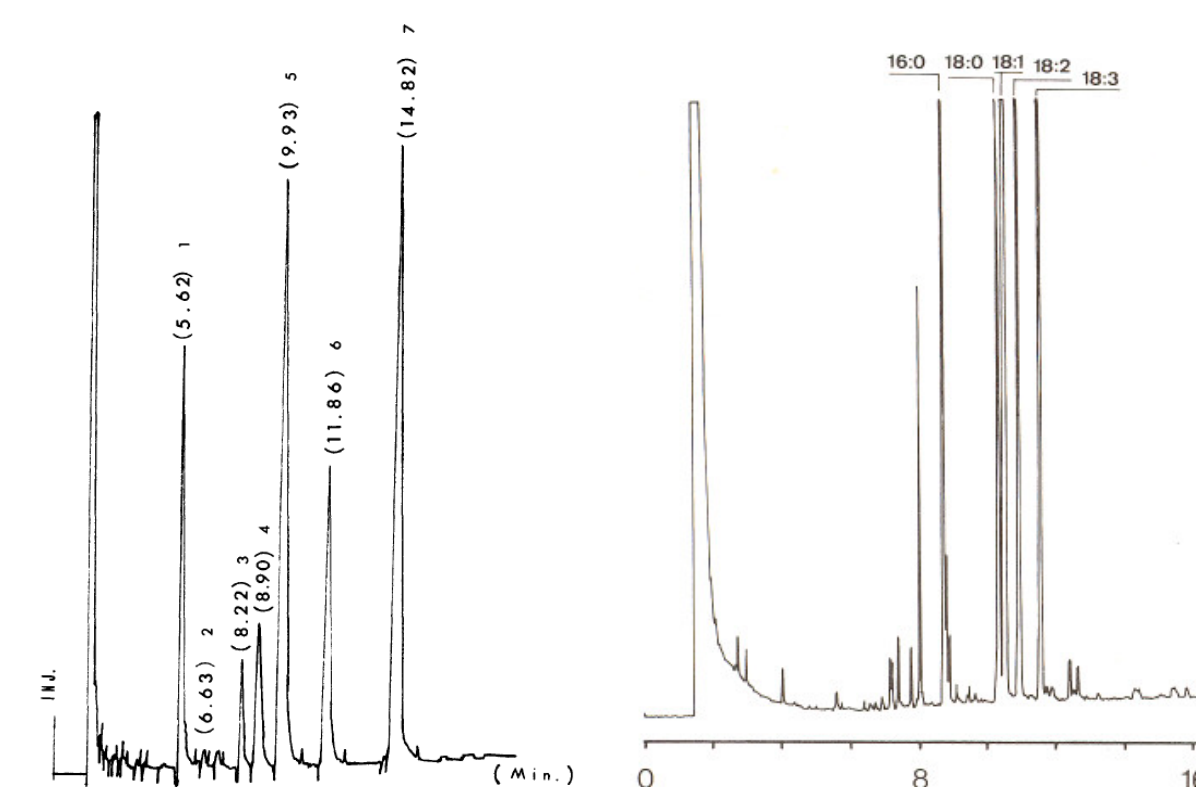
Figure 9. Left panel: Early GC with a glass capillary (isothermal mode) for binding media analysis (drying oil). Samples: fatty acids (as methyl esters). Numbering of acids: 1, palmitic (16:0); 2, suberic; 3, azelaic; 4, stearic (18:0); 5, oleic (18:1); 6, linoleic (18:2); 7, linolenic (18:3). For details see Supplementary Information and ref. [71] . From ref. [71] with permission. Right panel: T -programmed capillary GC. Sample: fatty acids (as methyl esters, after hydrolysis of the sample). Sample taken from the paste layer of a ceremonial shield from the Solo- mon Islands (collected mid-19 th century). Time in min. For numbering of analytes see Legend of left panel. For details see Supplementary Information and ref. [47] . From ref. [47] with